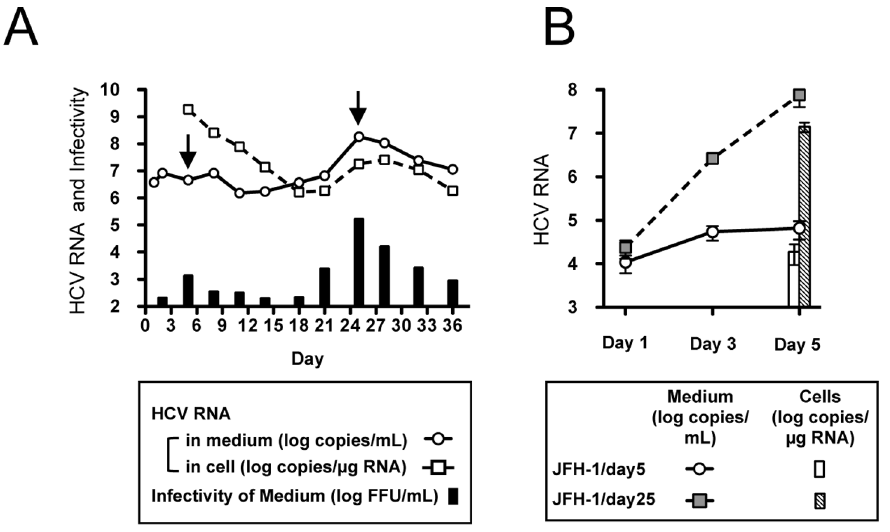
Figure 1. Isolation of cell culture-adapted JFH-1. (A) Long-term culture of JFH-1-transfected cells. The full-genome JFH-1 RNA was transfected into Huh-7.5.1 cells, and transfected cells were passaged for 3 to 4 days. HCV RNA titers in culture medium and cells were monitored. Arrows indicate the harvest points used for the infection study. (B) Production of progeny by infection with viruses harvested at day 5 and day 25 after transfection. The same amount of virus was used for infection at a multiplicity of infection (MOI) of 0.5, and HCV RNA titer was monitored.